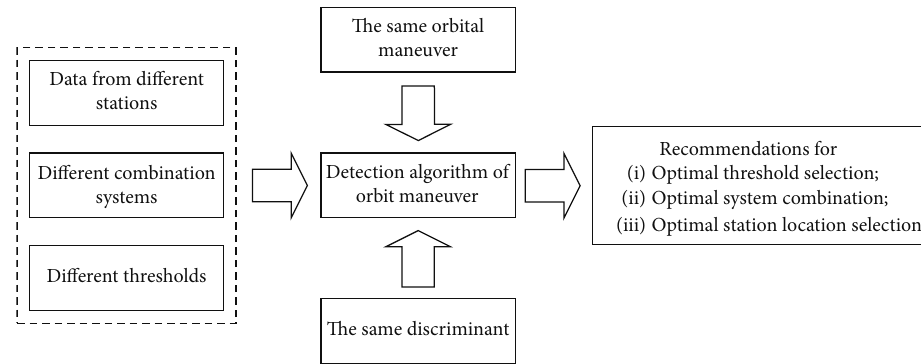
Figure 4: Implementation procedure for consistent and sensitive satellite orbit maneuver detection.